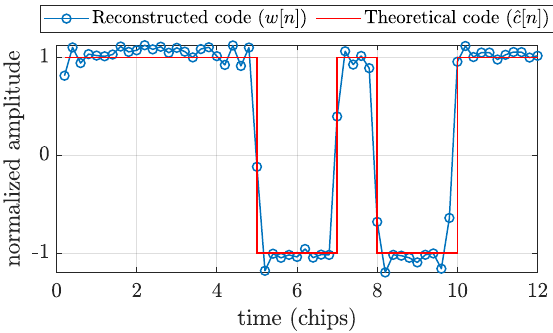
Figure 6. Reconstructed code with transition samples vs. theoretical